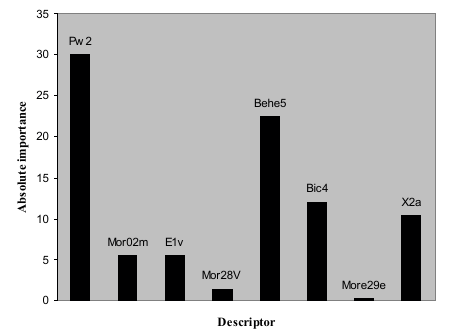
Figure 4. Absolute relative mean effects for MLR model Table 5. Obtained statistical parameters of L10O a cross-validation for STANN and GA-MLR models